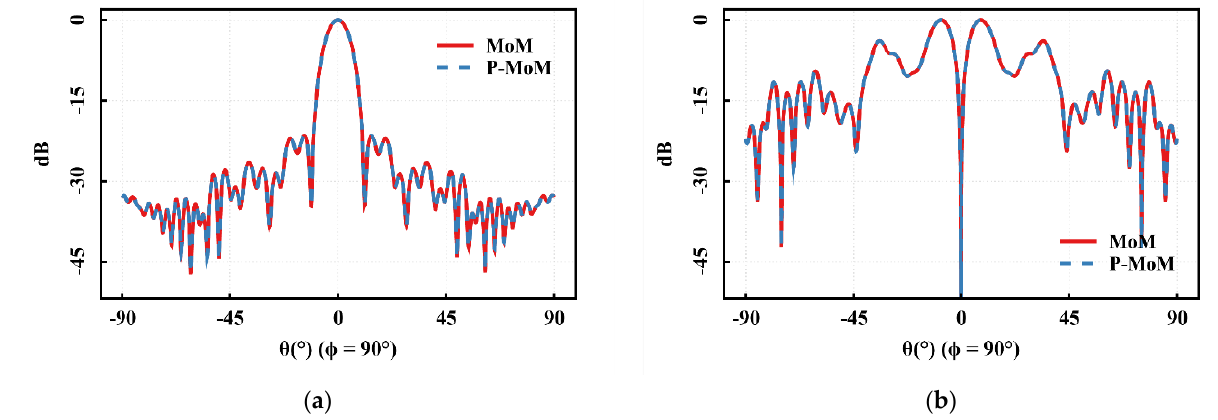
Figure 2. Patterns of the ARS obtained by MoM and P−MoM are compared to demonstrate the correctness of P − MoM: ( a ) Normalized sum pattern; ( b ) normalized difference pattern.